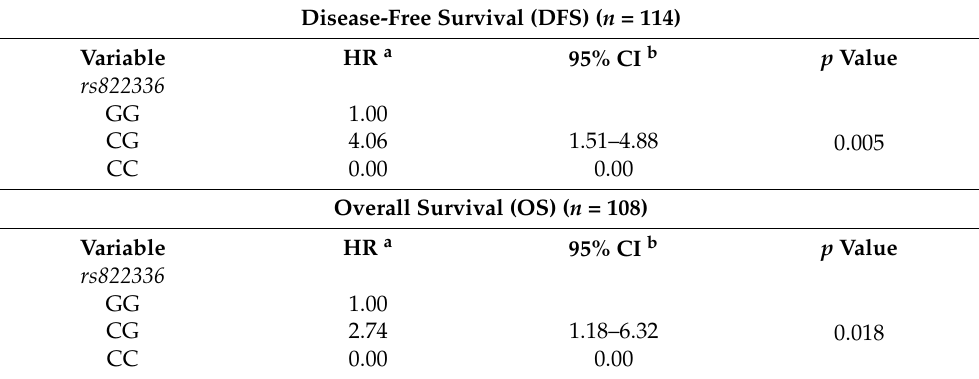
Table 2. Cox univariate regression analysis of rs822336 G>C for the prediction of disease-free (DFS) and overall survival (OS).